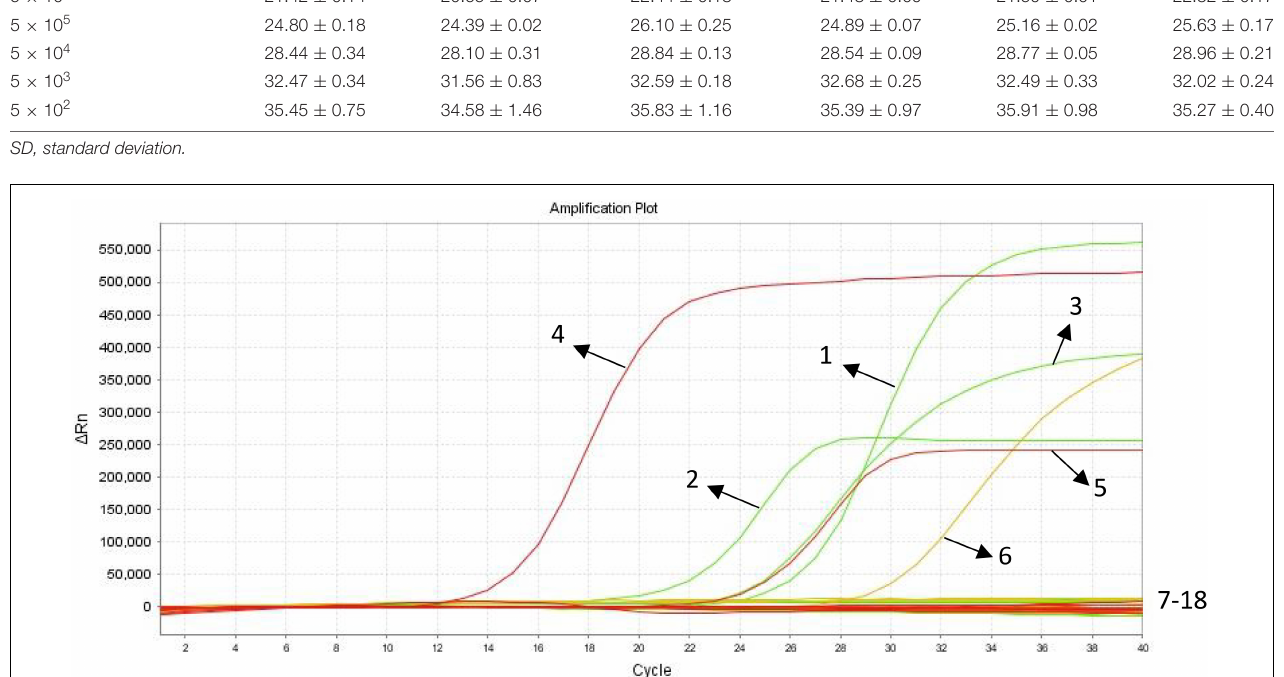
FIGURE 2 | Specificity analysis of triplex quantitative PCR (qPCR). (1) E. histolytica positive control(plasmid DNA Emh); (2) G. lamblia positive control(plasmid DNA Gla); (3) C. parvum positive control(plasmid DNA CryP); (4) E. histolytica positive control (genomic DNA); (5) G. lamblia positive control(genomic DNA); (6) C. parvum positive control(genomic DNA); (7–18) blank control, negative control, Cryptosporidium baileyi , Toxoplasma gondii , Clonorchis sinensis , Leishmania infantum , Ascaris lumbricoides , Paragonimus westermani , Taenia saginata , Taenia solium , Plasmodium ovale , Entamoeba coli.